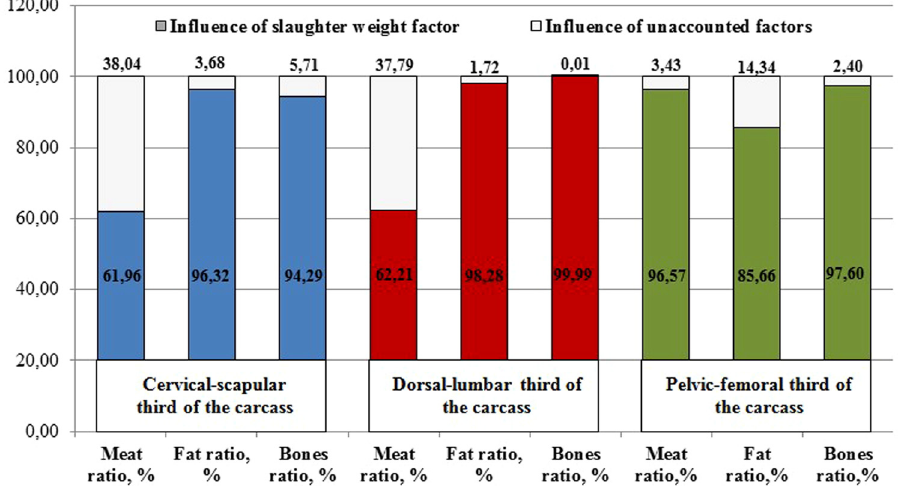
Figure 1: The strength of the in fl uence of slaughter weight factor on the morphological composition of pig carcasses ( source is own calculations ) .